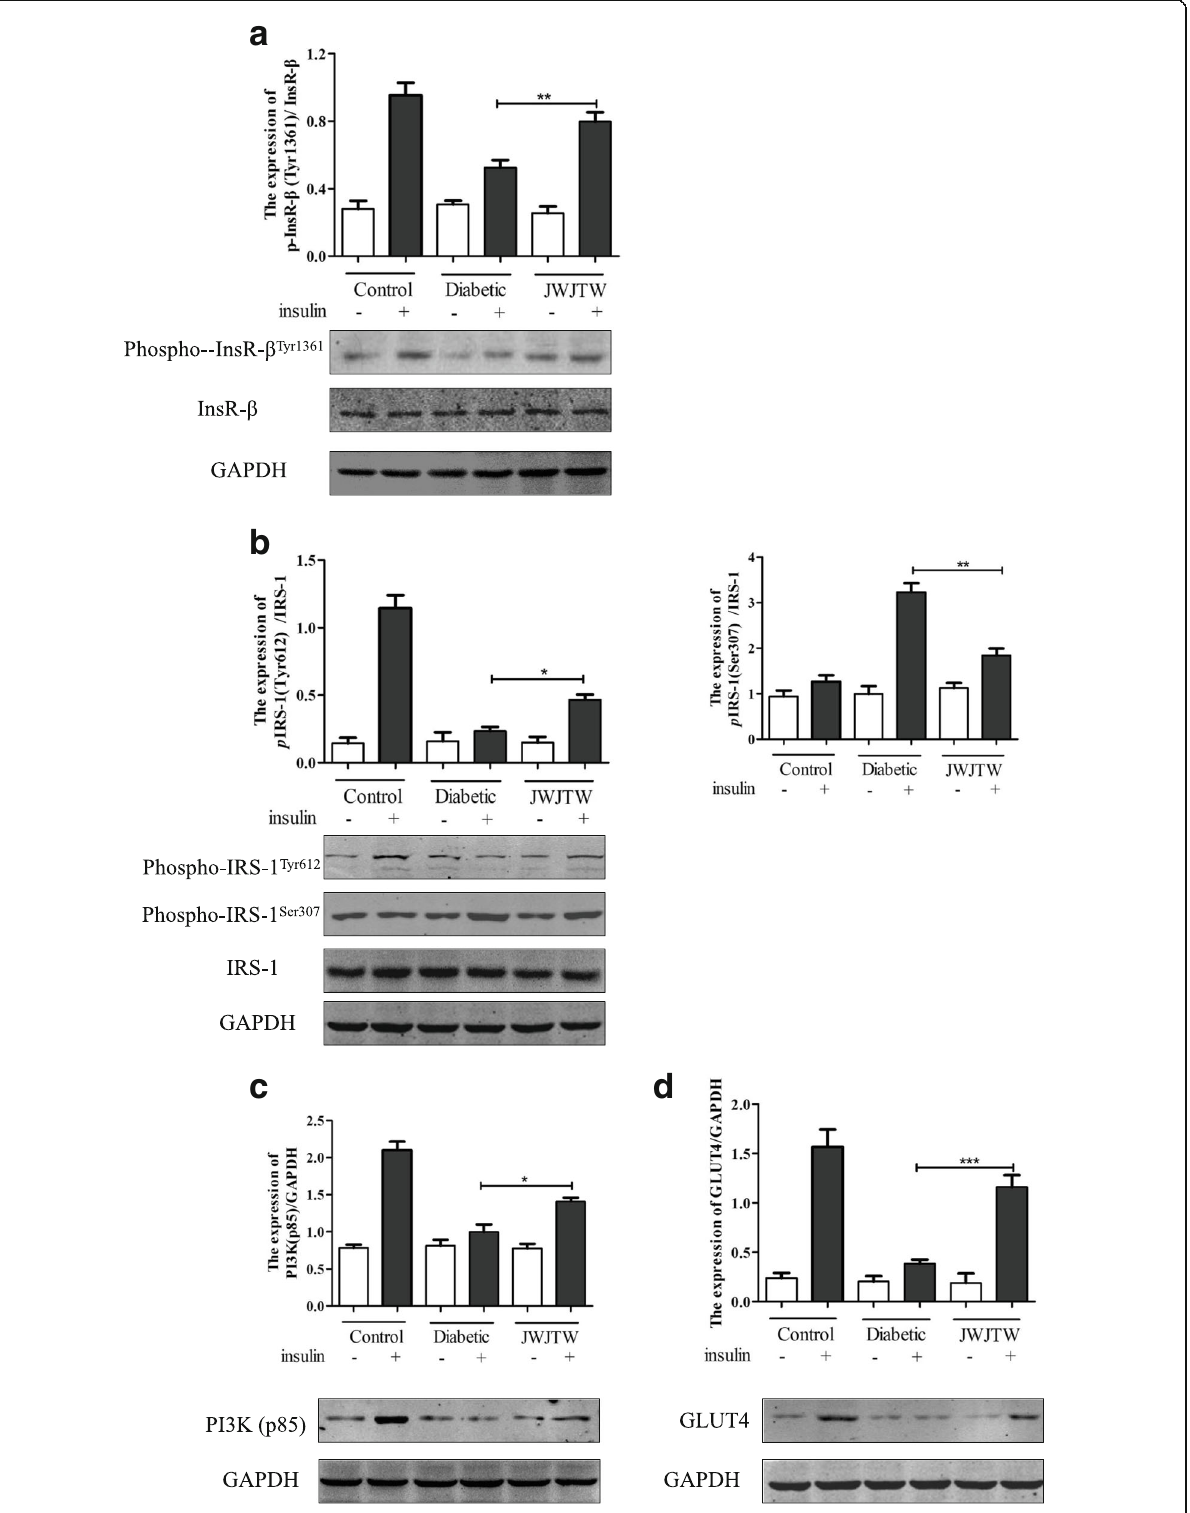
Fig. 8 Effect of JWJTW on insulin signaling in skeletal muscle of diabetic rats. Western blot analysis of phospho-InsR- β Tyr1361 ( a ), phospho-IRS-1 Tyr612 and phospho-IRS-1 Ser307 ( b ), PI3K (p85) ( c ) and GLUT4 ( d ). * p <0.05, ** p< 0.01, *** p <0.001 ( n